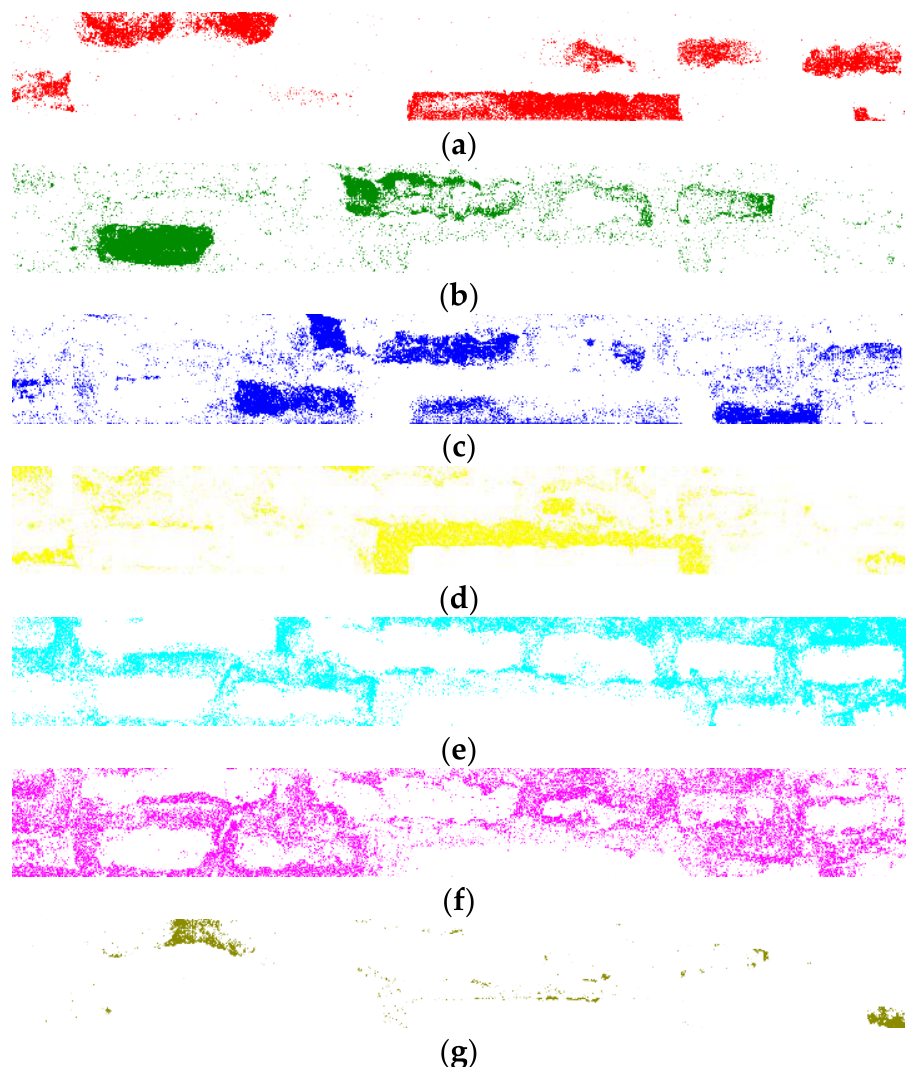
Figure 10. SAM classification results for ( a ) brick #1, ( b ) brick #2, ( c ) brick #3, ( d ) mortar #1, ( e ) mortar #2, ( f ) mortar #3, and ( g ) impregnated.